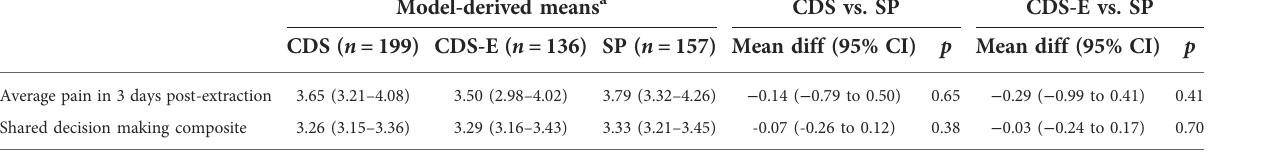
TABLE 2 Pain and shared decision-making measures by study